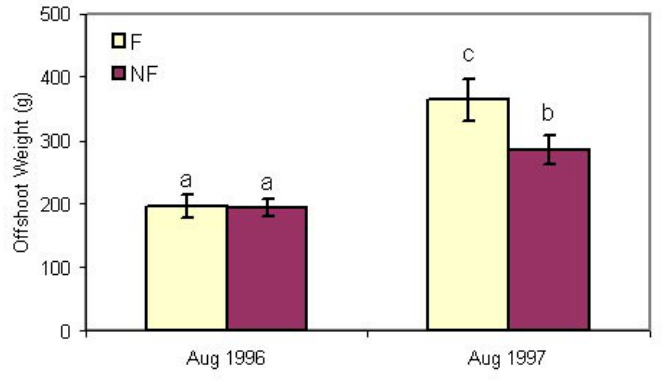
FIGURE 1 . Offshoot air dry weight (g) before planting and at the end of the experiment, grown under filtered and nonfiltered/fumigated conditions (see Table 1 for exposures). One-way ANOVA, different letters indicate significant differences (p <